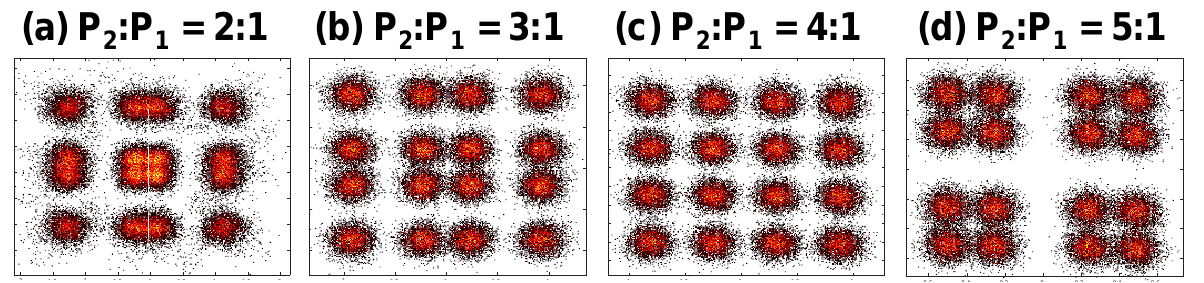
Figure 8. Experimental constellation diagrams of the power domain combined Data 1 and Data 2 OFDM-NOMA signals at different power ratios using QPSK.